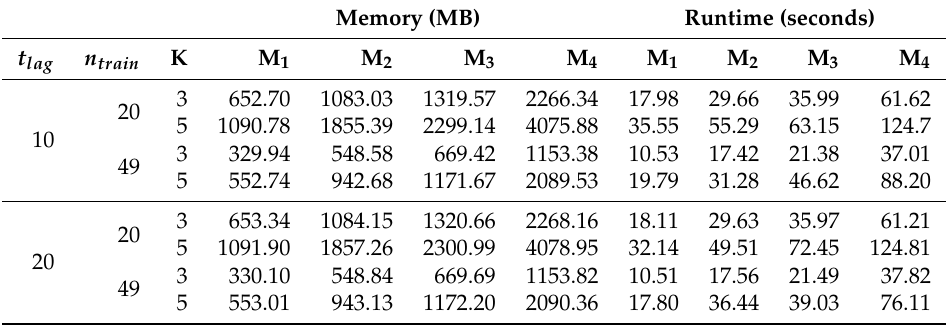
Table 4. Maximum memory consumption (MB) and computation time (seconds) for the four models tested, M i , following different strategies concerning the time lag, t lag , the size of the training sample, n train , and the number of basis functions,